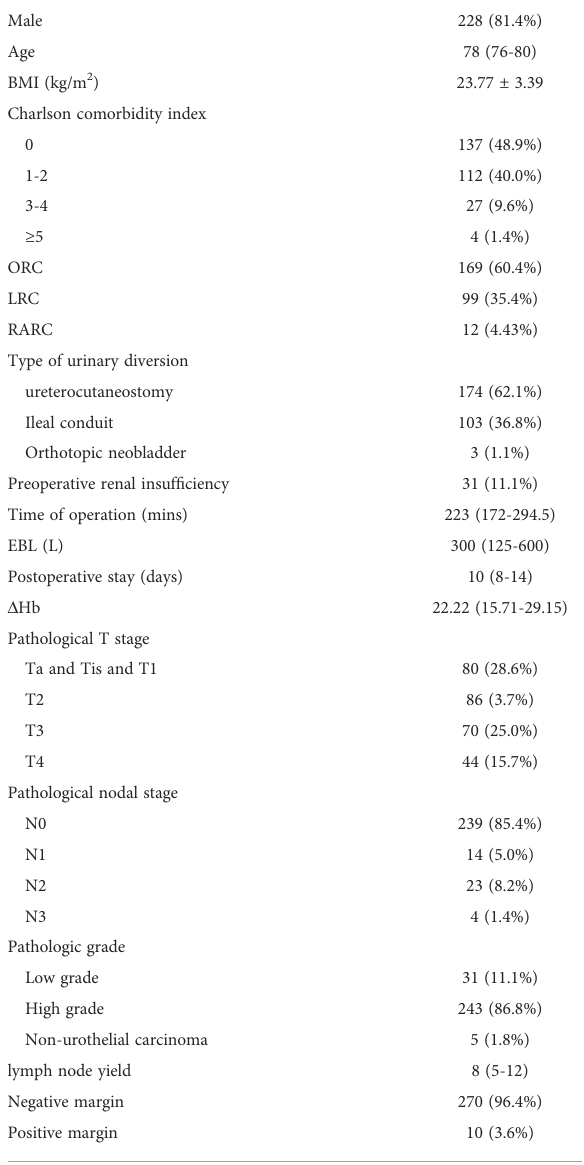
TABLE 1 The clinicopathologic characteristics of all